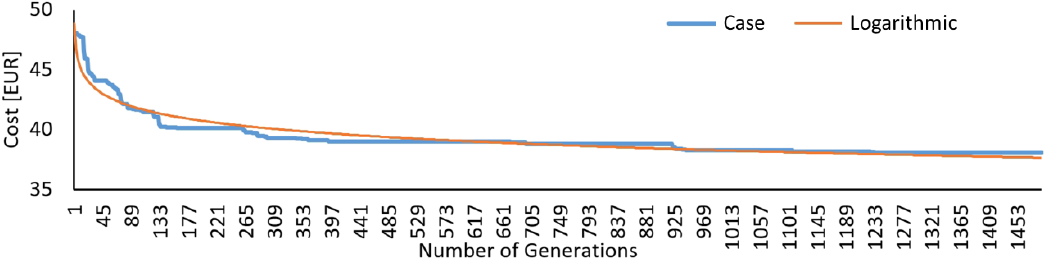
Figure 8. Energy consumption with energy costs.